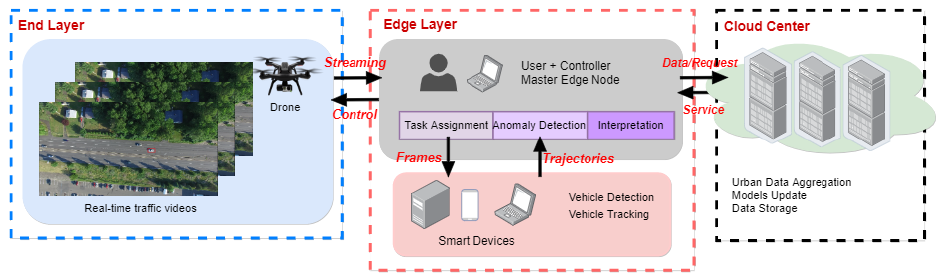
Figure 1. Overview of the SurMon